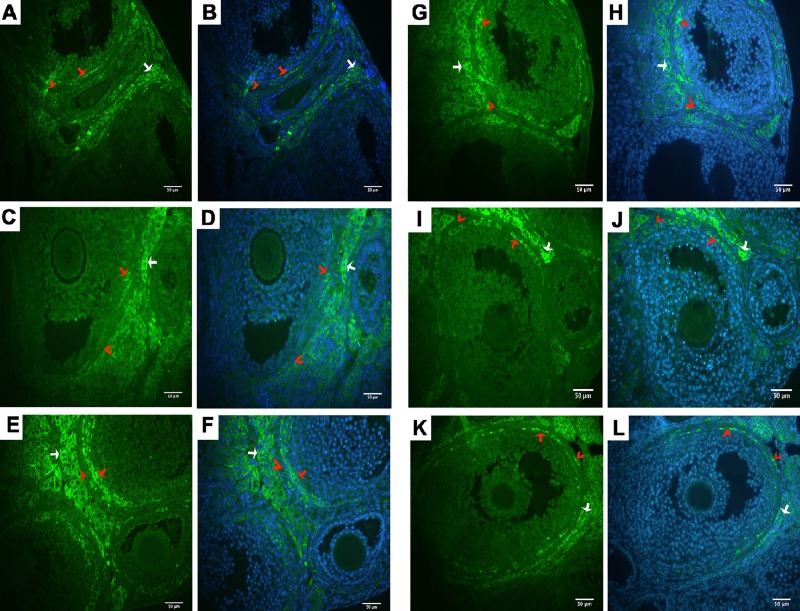
Immunofluorescence analysis of TDRD9, TDRD1, MAEL, MITOPLD, MILI, and MIWI in the ovarian tissue sections of the control group.Representative immunofluorescence images of TDRD9 (A-B), TDRD1 (C-D), MAEL (E-F), MITOPLD (G-H), MILI (I-J), and MIWI (K-L) (400X magnification). Red arrow, theca interna; Red arrow heads, theca externa; white arrow, stromal cells. MILI, MIWI, MAEL, TDRD1, TDRD9 and MITOPLD stained with FITC. Blue = DAPI nuclear counterstain, green = FITC.